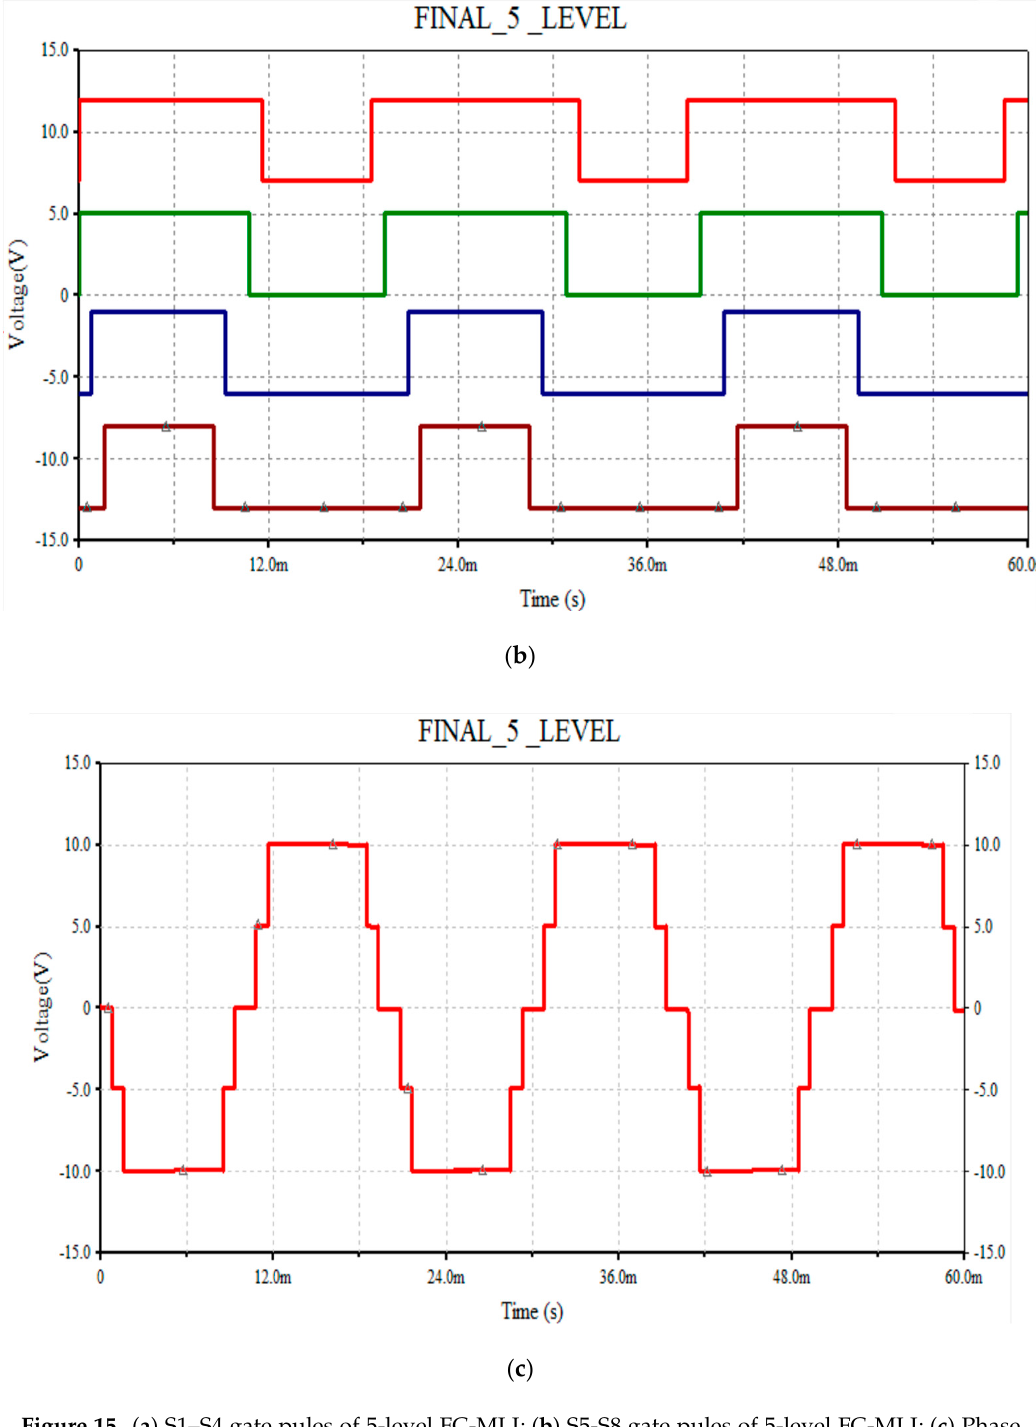
Figure 15. ( a ) S1–S4 gate pules of 5-level FC-MLI; ( b ) S5-S8 gate pules of 5-level FC-MLI; ( c ) Phase output voltage waveforms of a 5-level FC-MLI using MULTISIM.